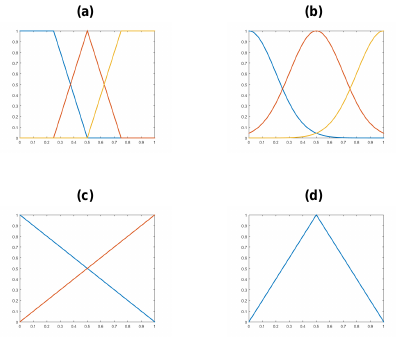
Fig. 1: Some of typical fuzzi(cid:28)cation methods